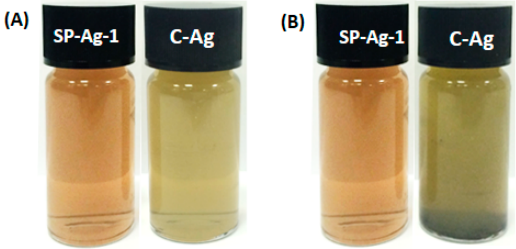
Figure 10. The green synthesized Ag-NPs display better dispersion quality when compared to the chemically synthesized Ag-NPs ( A ) 0 min; ( B ) After two days.